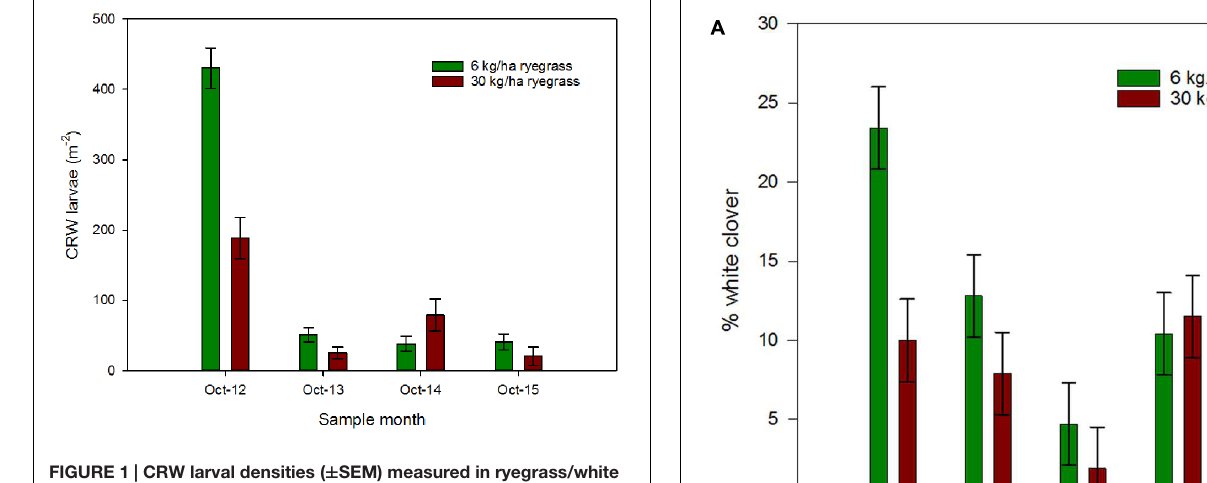
FIGURE 1 | CRW larval densities ( ± SEM) measured in ryegrass/white clover swards consisting of ryegrass sown at 6 or 30 kg/ha and white clover sown at 8 kg/ha.